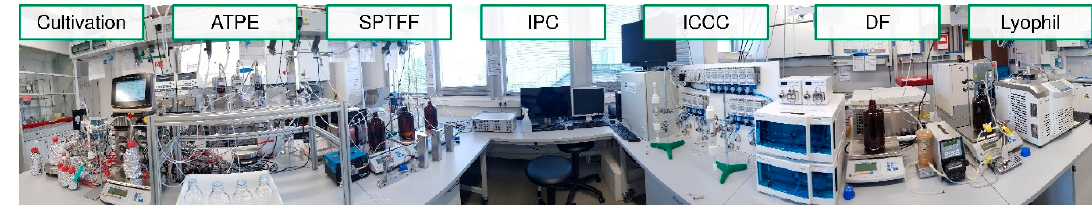
Figure 13 Figure 13. Mini-plant for model validation and piloting at the